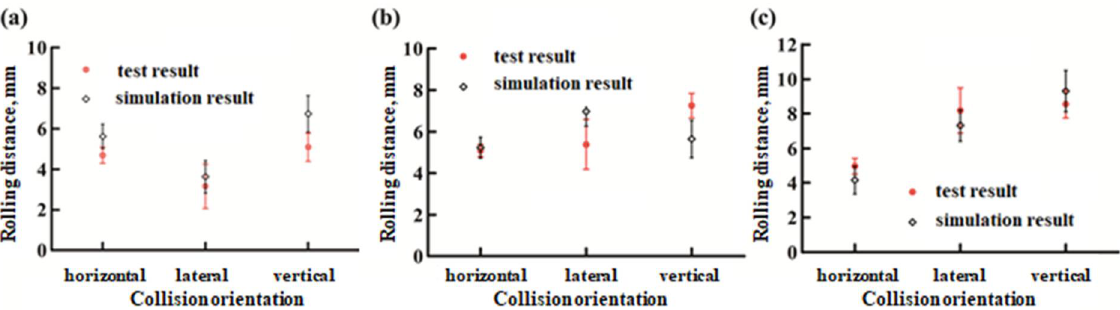
Figure 15. The relationship between rolling distance and collision orientation for ( a ) SN42, ( b ) JD17 and ( c ) ZD39.